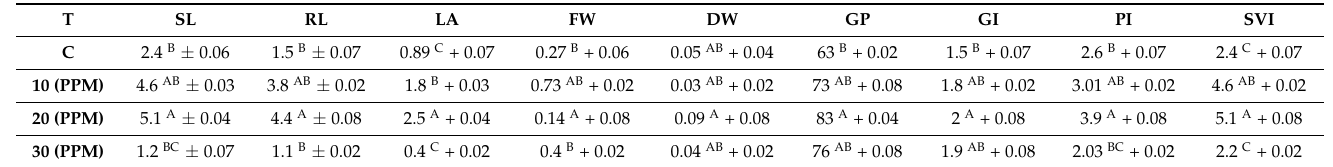
Table 2. Germination and biomass studies of Zea mays L. treated with different concentrations of TiO 2 NPs (10, 20, and 30 ppm) in a Petri plate